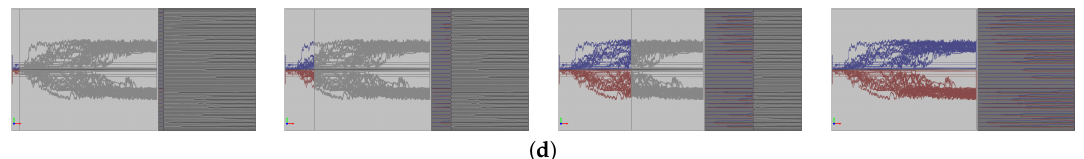
Figure 13. Overview visualizations for different time steps (columns). The selected time step is highlighted in the plots in the last row as vertical lines. The upper rows show different volumetric visualizations of the ensemble focusing on the different tasks. ( a ) charge coverage volume within context morphology (Task OE); ( b ) progression of the trajectory ensemble with time (Task OE, ME); ( c ) density projection of the trajectory ensemble (Task ME); ( d ) summary plot distance to start position (Task OE, CI).